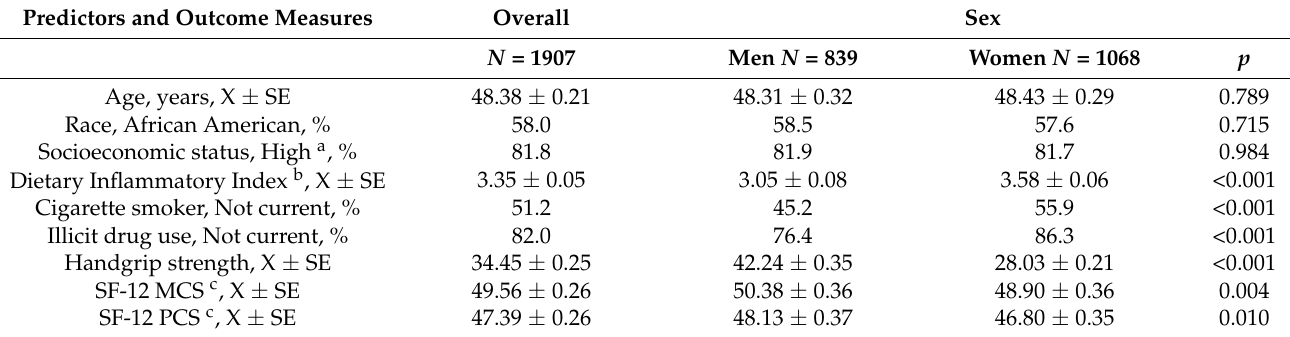
Table 1. Characteristics of HANDLS study sample at Visit 1,